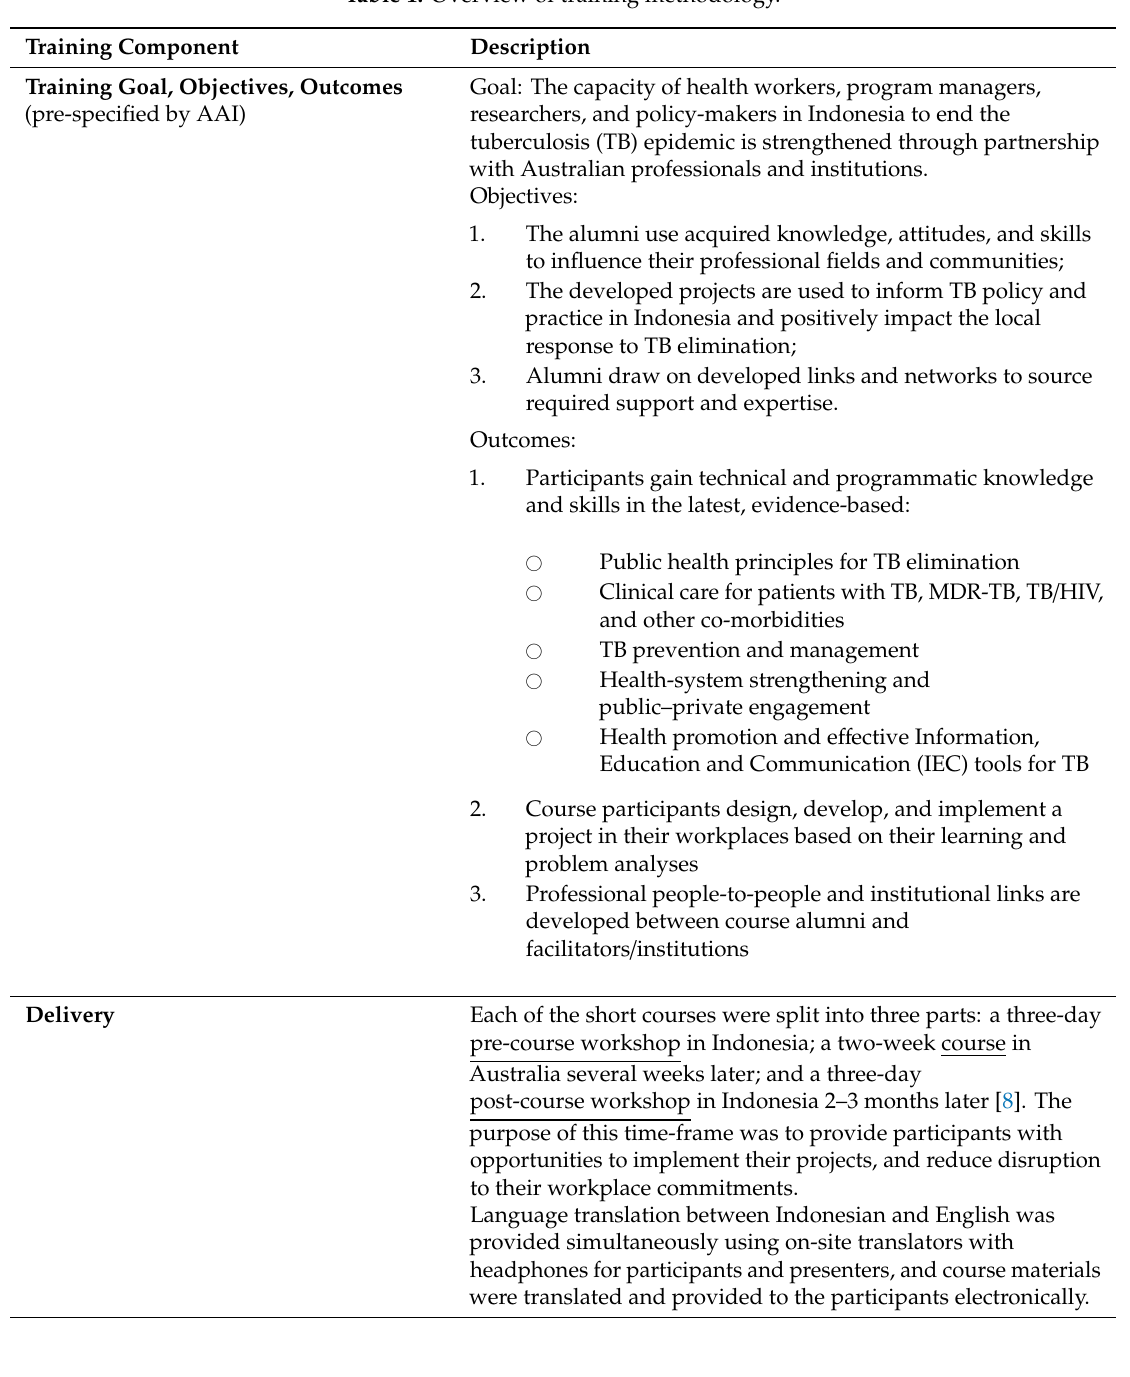
Table 1. Overview of training